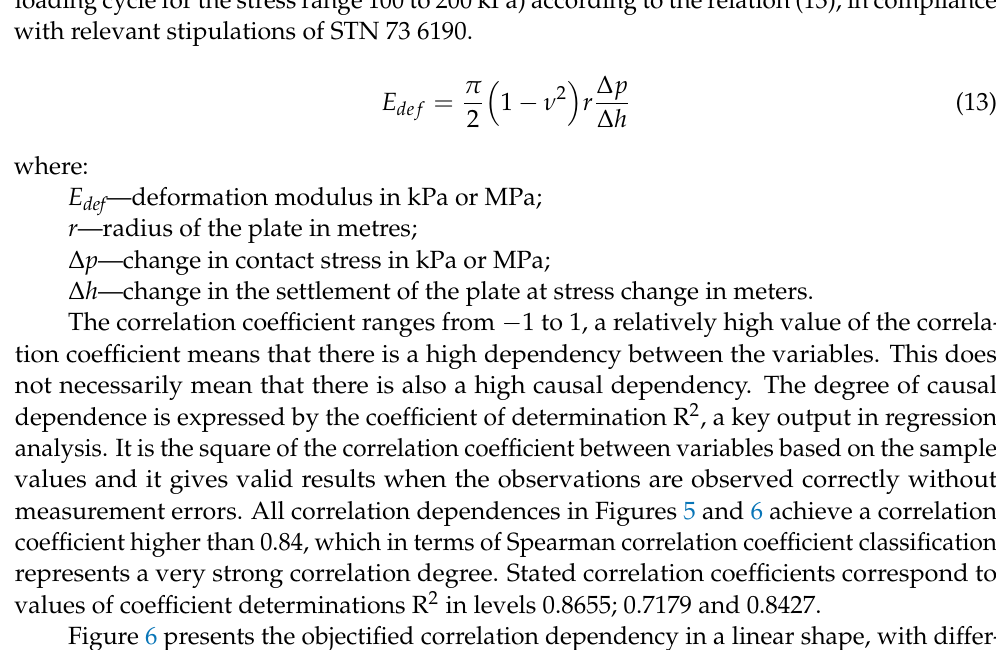
Figure 5. Power correlation dependency of E def, 2 on E vd during the years 1995–2010. The values of E vd were determined according to Equation (11) and values E def, 2 (second loading cycle for the stress range 100 to 200 kPa) according to the relation (13), in compliance with relevant stipulations of STN 73 6190.